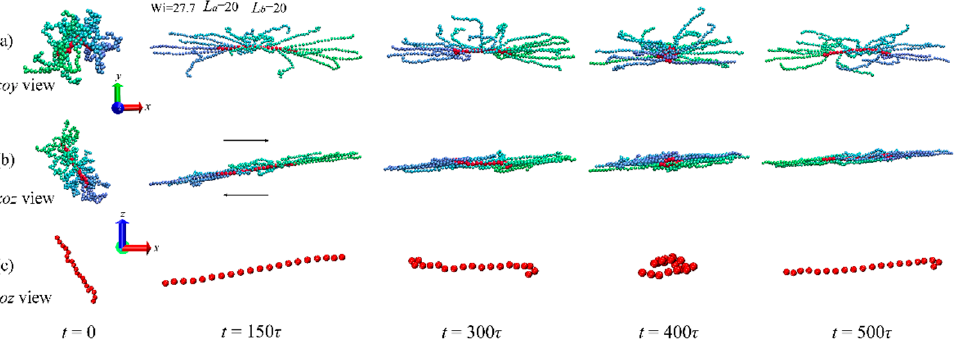
Figure 1. ( a ) xoy view and ( b ) xoz view of conformations of the LCB polymer with L b = 20, L a = 20 in shear flow of Wi = 27.7 at various time steps. ( c ) The xoz view of the backbone of the above polymer. To gain more insights into the tumbling and rotation behaviors, we perform a statistic on structural properties of the LCB polymer in shear flow with Weissenberg number Wi = 27.7 for time steps. The end-to-end distance of the backbone, the angle that the backbone’s end-to-end vector makes with respect to the flow direction in the flow-gradient plane ( xoz plane) and the mean end-to-end distance of arms are shown in Figure 2a, b and c, respectively. Figure 2a shows a periodic curve for the end-to-end distance of the backbone; (cid:12) (cid:12) that is, the (cid:12) R ete , back (cid:12) of the polymer increases to a value larger than its contour length L b = 20 and then gradually decreases to a value smaller than one half of its contour